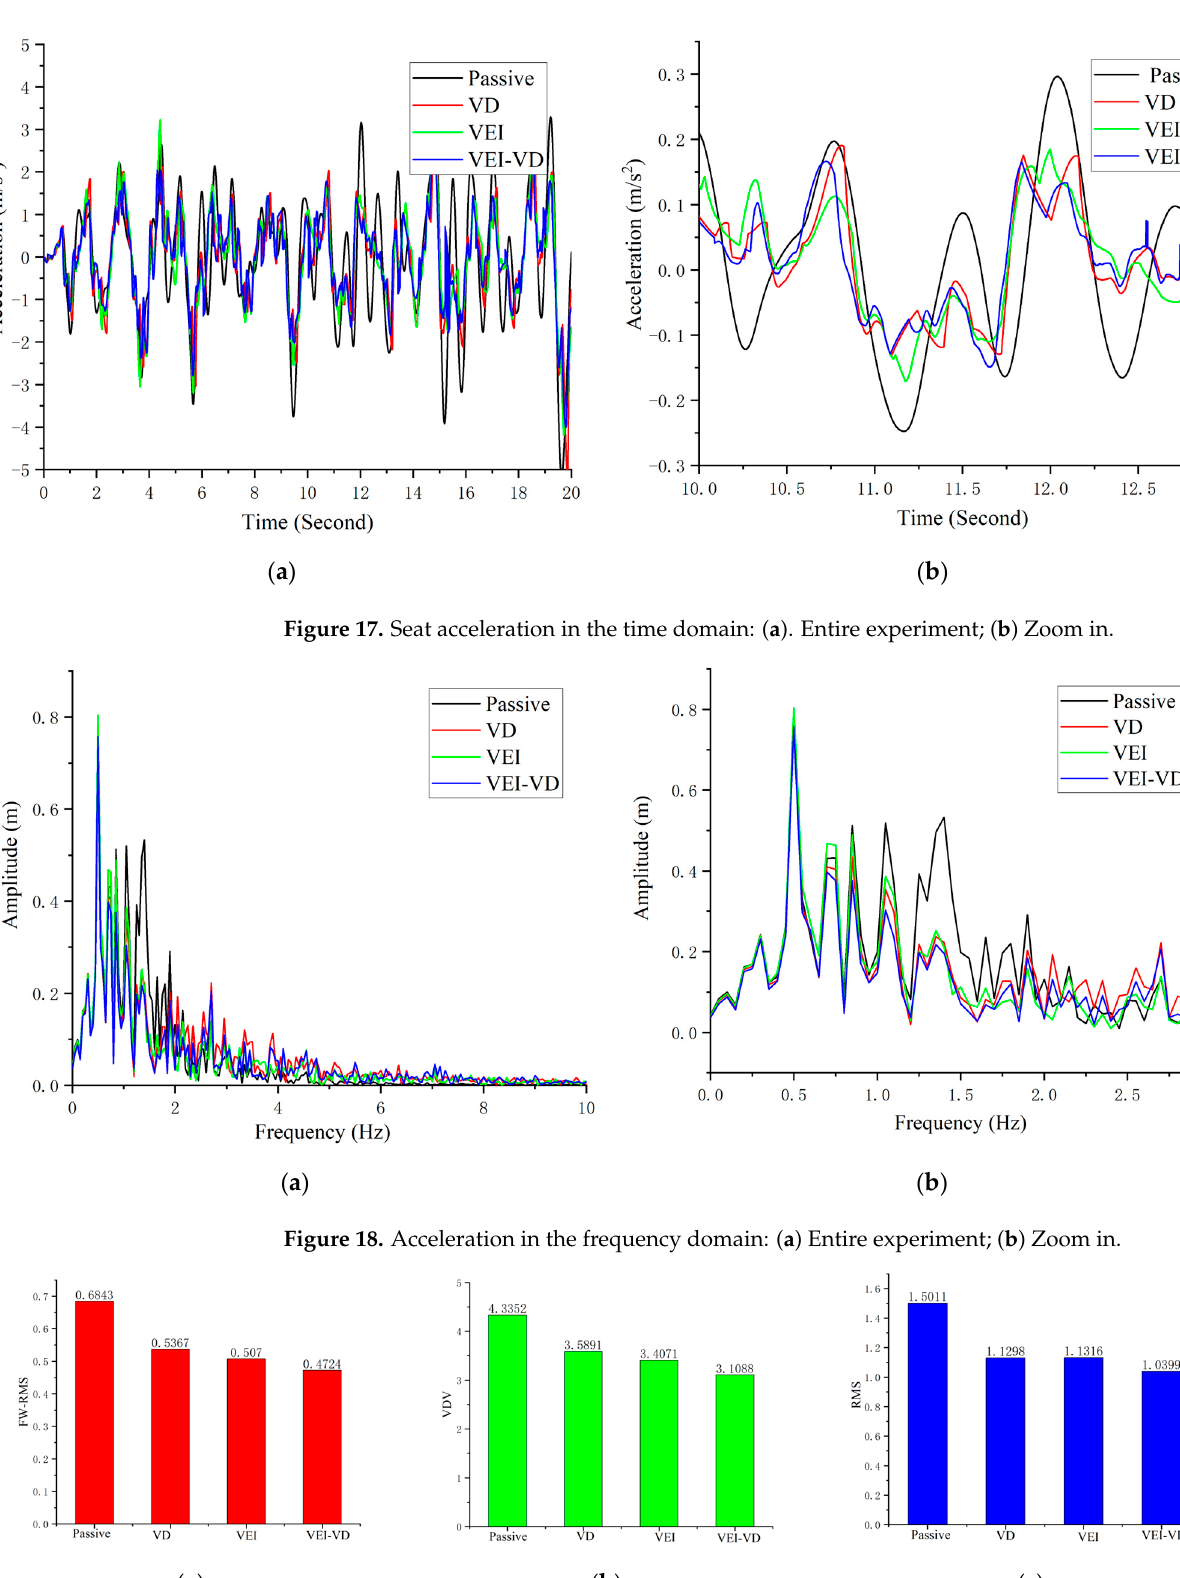
Figure 19. Evaluation parameters of seat acceleration: ( a ) FW-RMS; ( b ) VDV; ( c ) RMS. Table 3. Vibration reduction compared to passive. 417